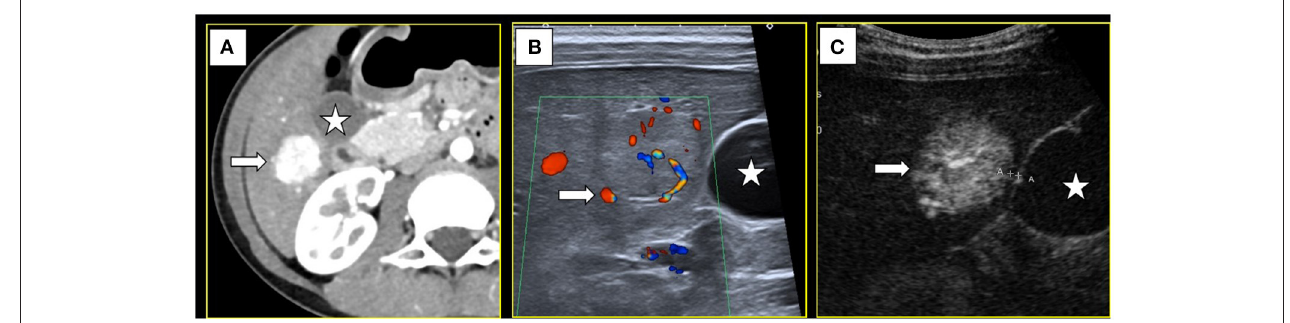
FIGURE 1 | (A) Computed tomography showed a S5 lesion ( → ) with hyper-enhancement in arterial phase and near the gallbladder( ⋆ ). (B) Color Doppler ultrasound showed the feeding artery ( → ). (C) Contrast-enhanced ultrasound showed the lesion had hyper-enhancement in arterial phase ( → ) and only 1mm away from the gallbladder( ⋆